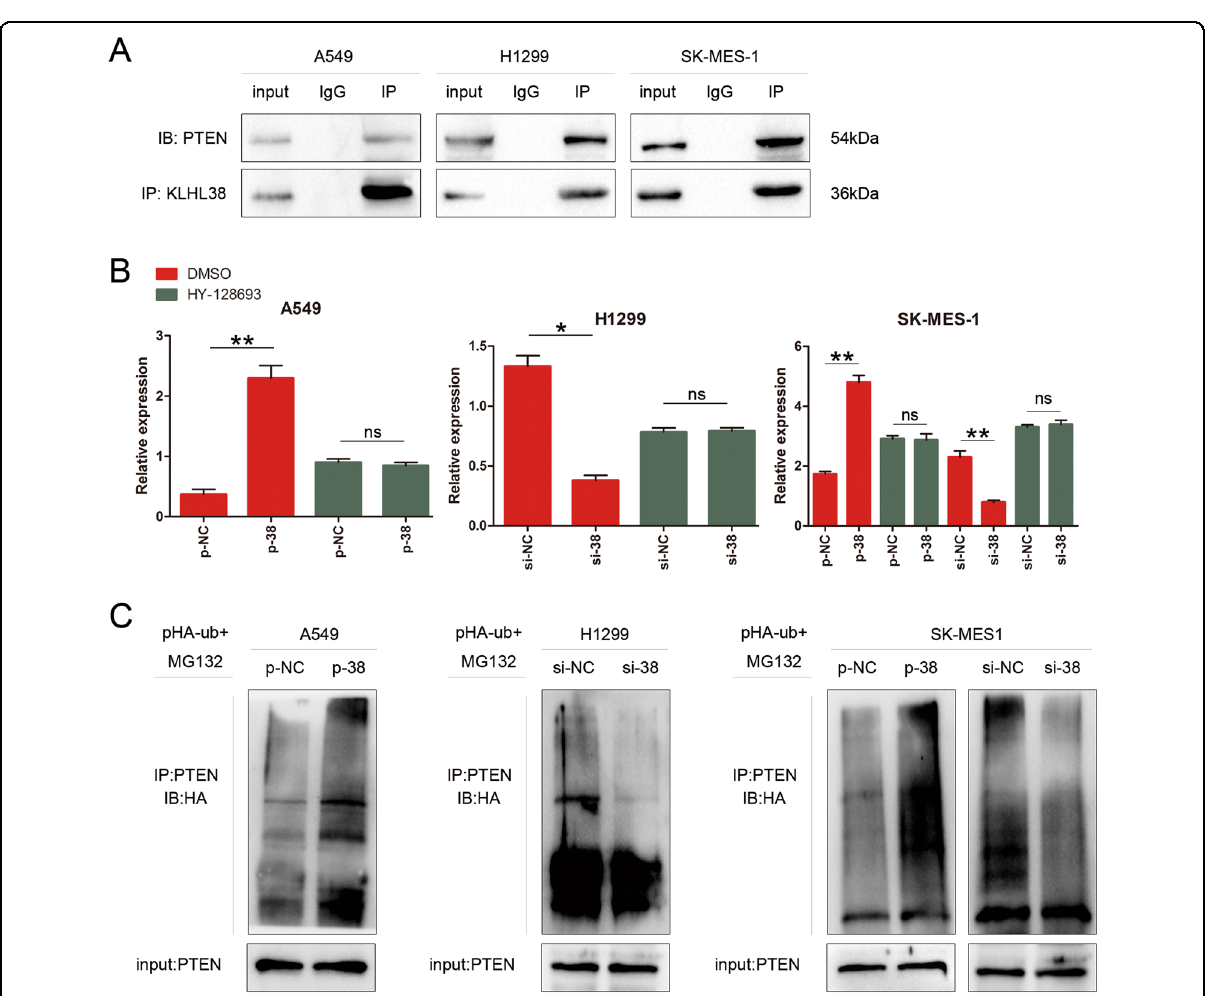
Fig. 5 Relationship between KLHL38 and PTEN. A Interactions between KLHL38 and PTEN in A549, H1299, and SK-MES-1 cells measured by co- immunoprecipitation. B PTEN levels in A549, H1299, and SK-MES-1 cells upon up- or downregulation of KLHL38 expression. C A549, H1299, and SK- MES-1 cells were transfected with a KLHL38 -speci fi c siRNA or pCMV6-myc-DDK- KLHL38 along with HA-ubiquitin (Ub). Levels of PTEN ubiquitination were evaluated by immunoprecipitation using an anti-PTEN antibody, followed by anti-HA immunoblotting. p-NC, cells transfected with pCMV6-myc- DDK; p-38, cells transfected with pCMV6-myc-DDK- KLHL38 ; si-NC, cells transfected with scrambled control siRNA; si-38, cells transfected with KLHL38 - speci fi c siRNA. All experiments were repeated three times, error bars as